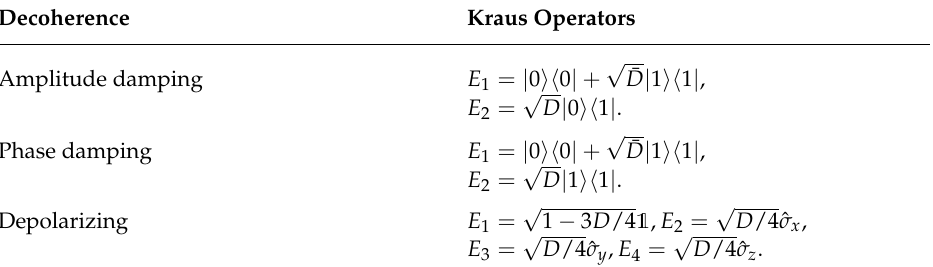
Table 1. Kraus operators representing three types of decoherence. Here, 0 ≤ D ≤ 1 is the magnitude of the decoherence and ¯ D = 1 − D . ˆ σ x , y , z are the Pauli matrices. Decoherence Kraus